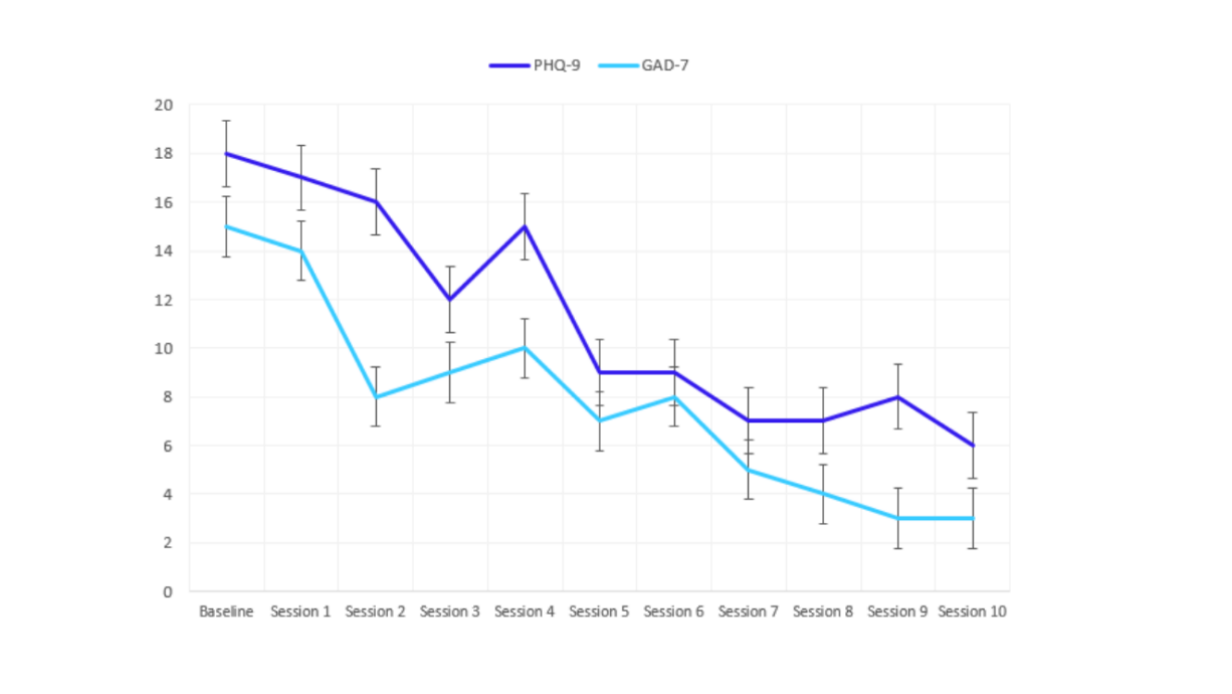
Figure 2. Patient self-monitoring data graphed on the Eleos platform. GAD-7: Generalized Anxiety Disorder-7; PHQ-9: Patient Health